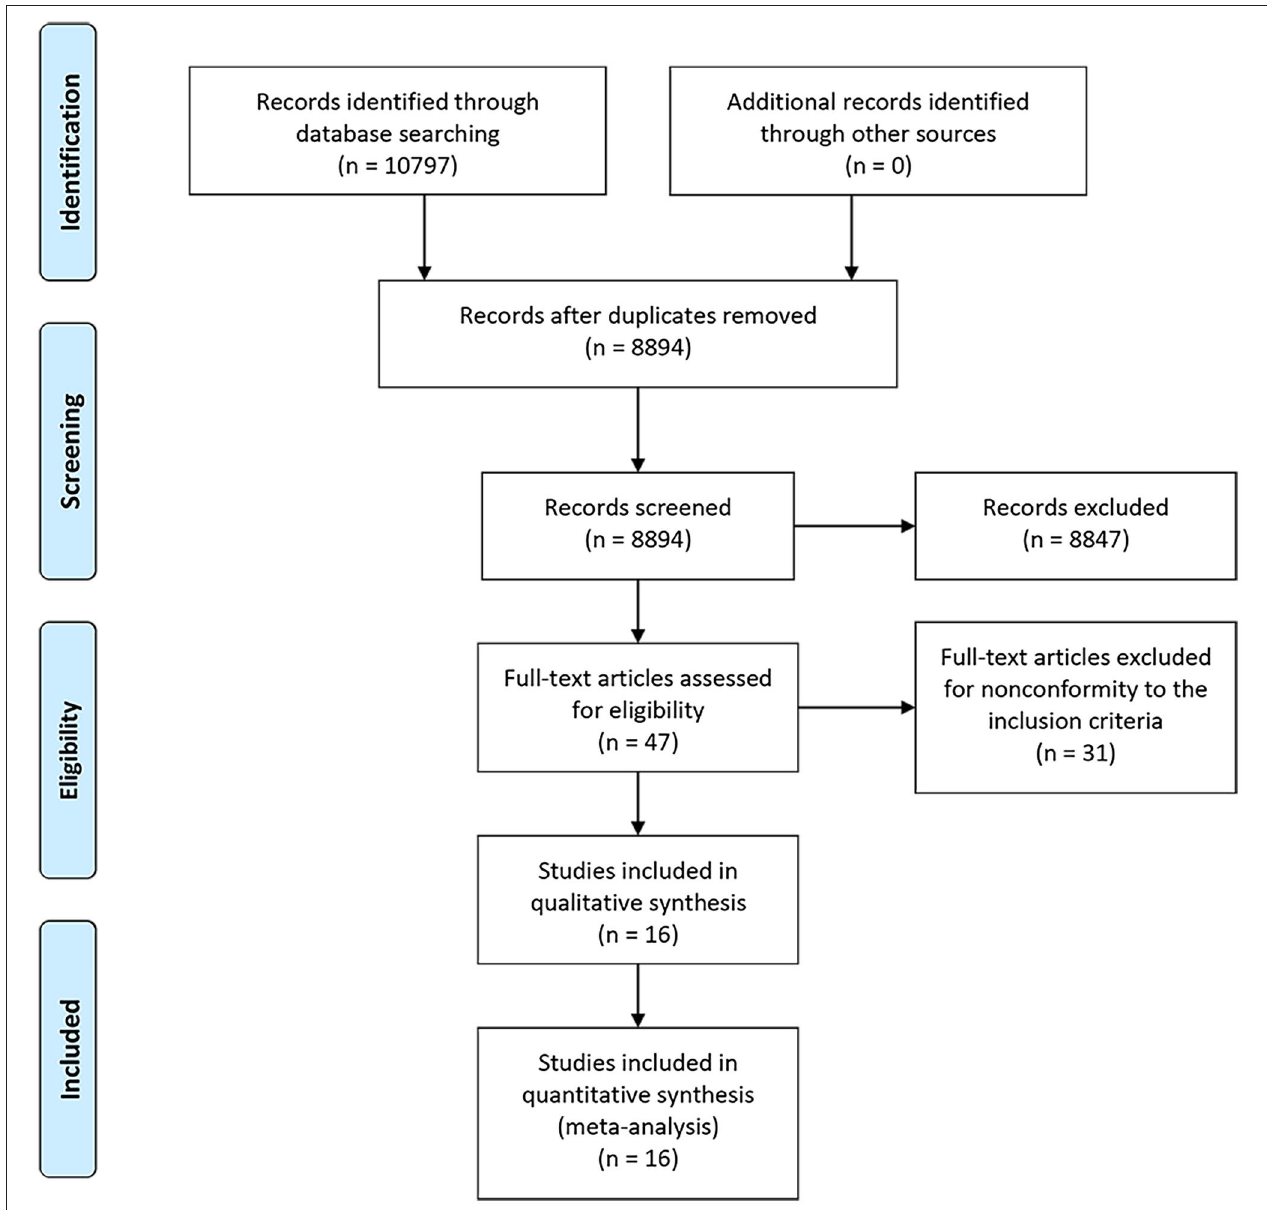
FIGURE 1 | PRISMA flowchart of study